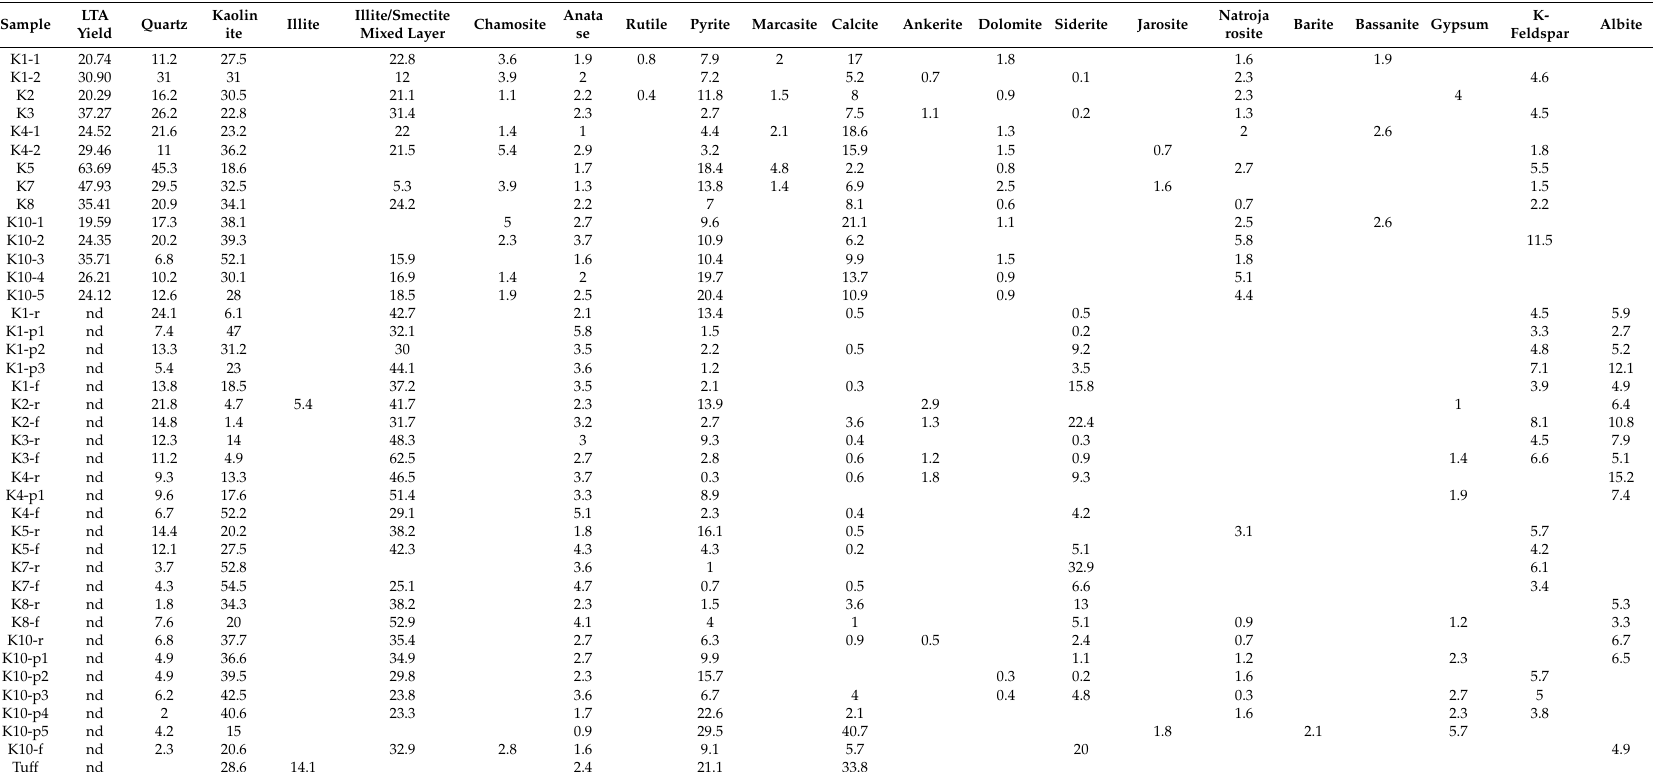
Table 2. Mineral compositions of coal LTAs and non-coal samples by X-ray diffraction (XRD) and Siroquant analysis (wt